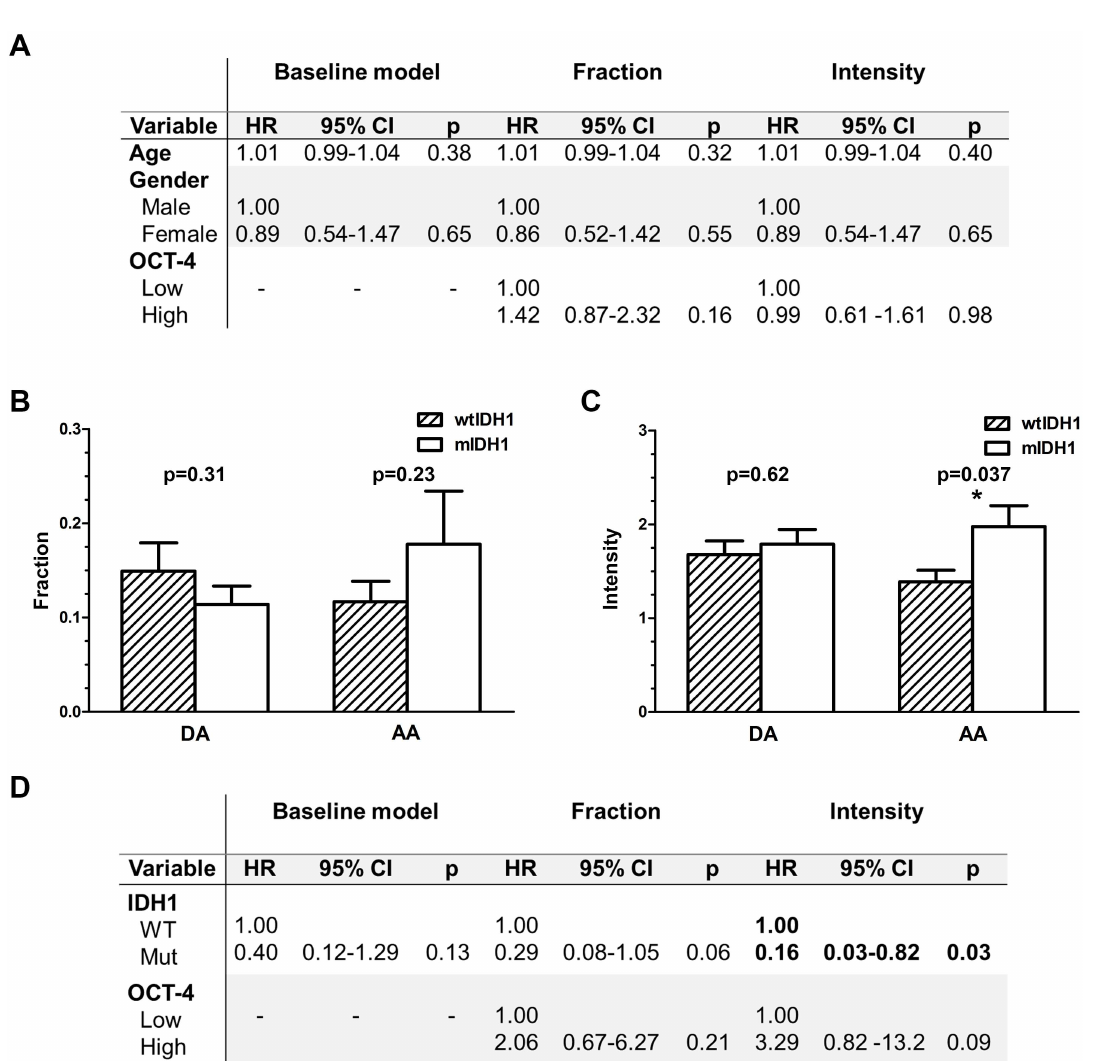
Fig 4. Multivariate analysis and association between Oct-4 and IDH1 status. (A) Oct-4 did not have any independent prognostic value in glioblastomas when genderand age were taken into account. (B) No significantdifference in Oct-4 fraction was found for IDH-1 wildtype(wtIDH1) and IDH-1 mutated (mIDH1) tumors, neither for diffuse astrocytomas (p = 0.31) nor for anaplastic astrocytomas (p = 0.23). (C) For Oct-4 intensity the same results were obtainedin diffuse astrocytomas (p = 0.62), whilefor anaplastic astrocytomas mIDH1 tumors showedhigherintensity than wtIDH1 tumors (p = 0.037). (D) Performing multivariate analysison patients with anaplastic astrocytomas, mIDH1predictedimproved survival (p = 0.03), while high Oct-4 tendedto be associatedwith poor prognosis(p =